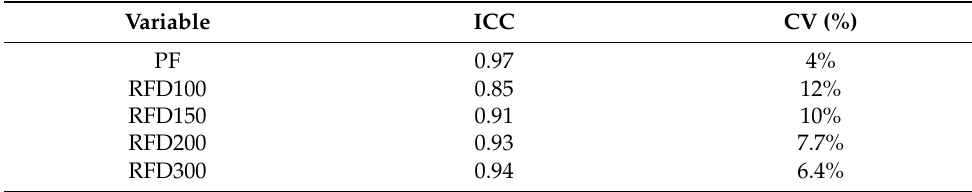
Table 5. Reliability of IMTP